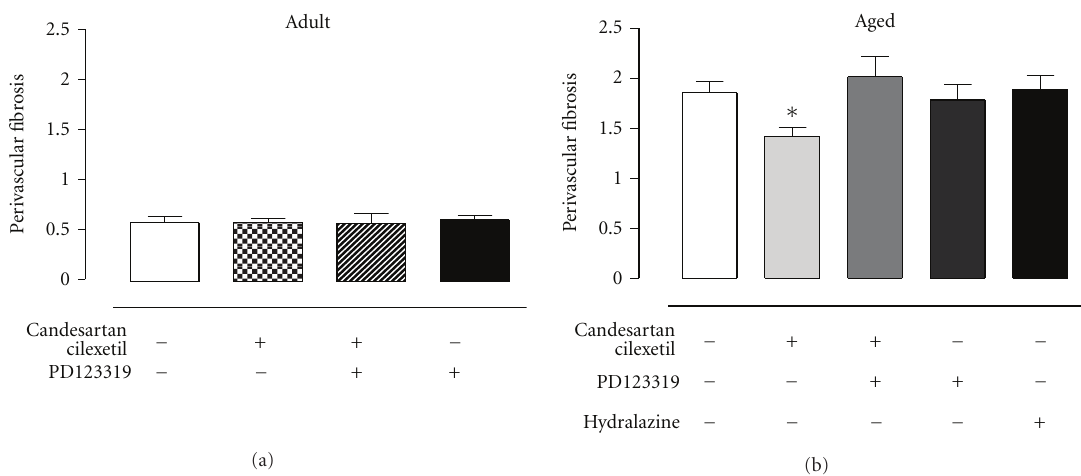
Figure 5: (a) Perivascular fibrosis of adult SHRs treated with vehicle (control, n = 6), candesartan cilexetil (2mg/kg/day) alone ( n = 7) or in combination with PD123319 (10mg/kg/day, n = 7), or PD123319 alone ( n = 7). (b) Perivascular fibrosis of senescent SHRs treated with vehicle (control, n = 10), candesartan cilexetil alone ( n = 9) or in combination with PD123319 ( n = 9), PD123319 alone ( n = 4), or hydralazine (30mg/kg/day, n = 7). Perivascular fibrosis of intramyocardial arterioles, calculated as cross-sectional area of adventitia to lumen ratio. ∗ P < 0 . 05 versus control (1-way